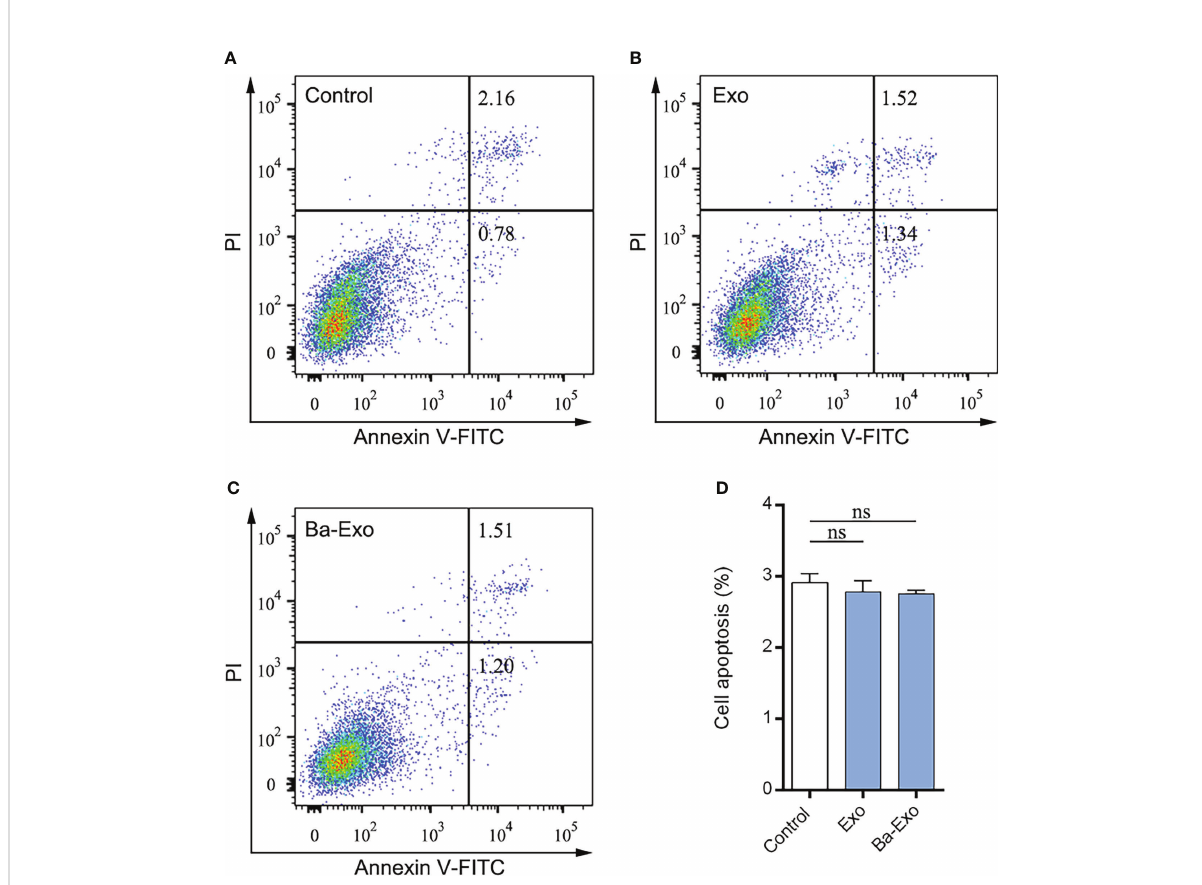
FIGURE 5 Evaluation of apoptosis levels were determined. Dulbecco ’ s phosphate buffered saline – treated 3D4/21 served as a negative control (A) . The 3D4/21 apoptosis levels were measured by fl ow cytometry after Exo (B) and Ba-Exo (C) pretreatment. (D) , Quanti fi cation of apoptotic cells in 3D4/21. Mean ± SD of three independent experiments are shown. SD, standard deviation; ns, not signi fi